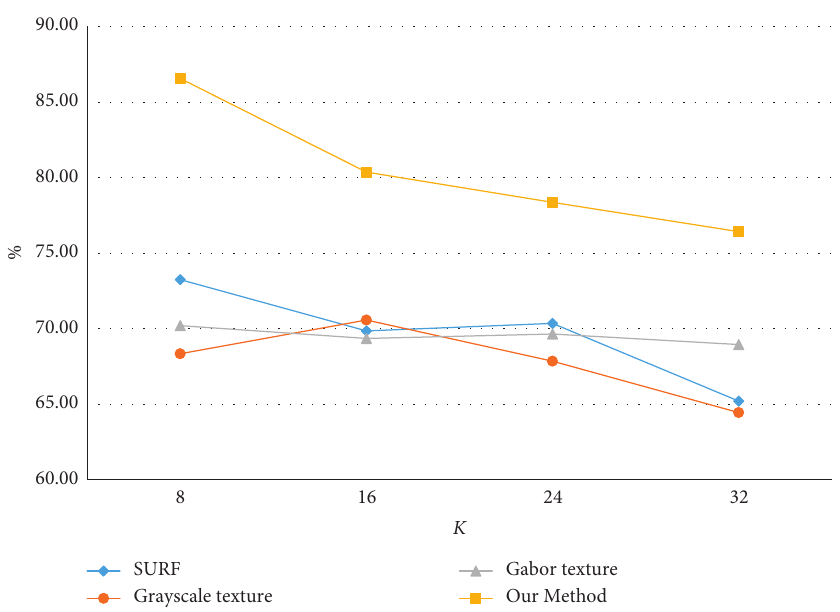
Figure 9: Comparison of features of lung medical